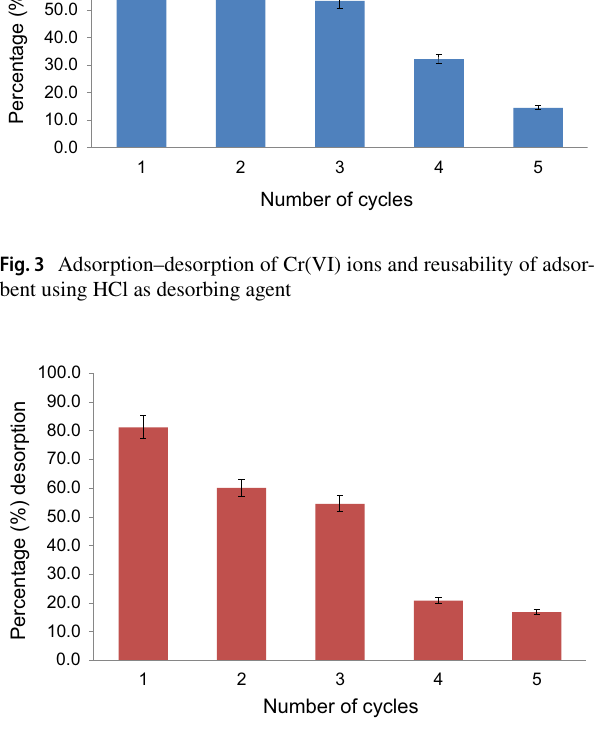
Fig. 4 Adsorption–desorption of Pb(II) ions and reusability of adsor- bent using H 2 SO 4 as desorbing